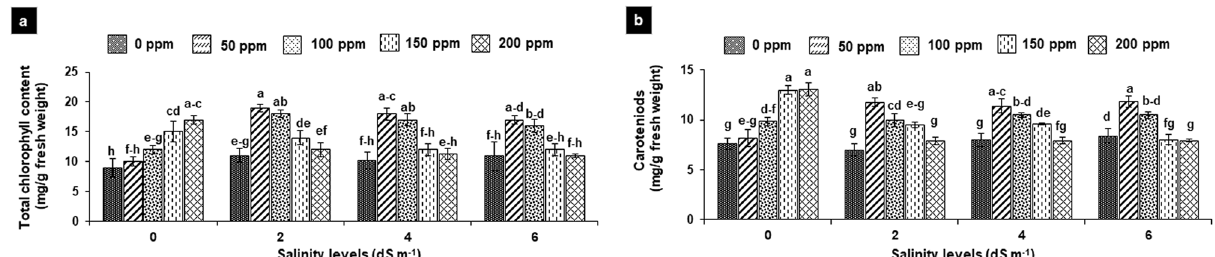
Figure 3. (a,b) Effects of foliar application of salicylic acid on the total chlorophyll content ( a ) and carotenoids ( b ) in Gladiolus grandiflorus irrigated with saline water. Vertical bars show standard errors of means of three replicates. Different letters indicate significant differences (P < 0.05) according to LSD test; the same letter indicates no significant differences between the